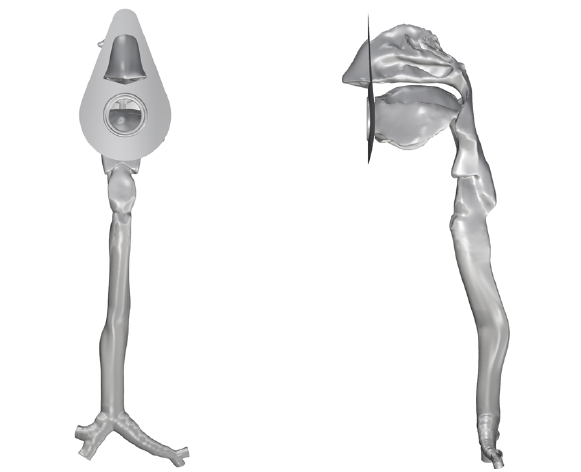
Fig. 2. Front view and side view of the rescaled STL geometry used in this simulation